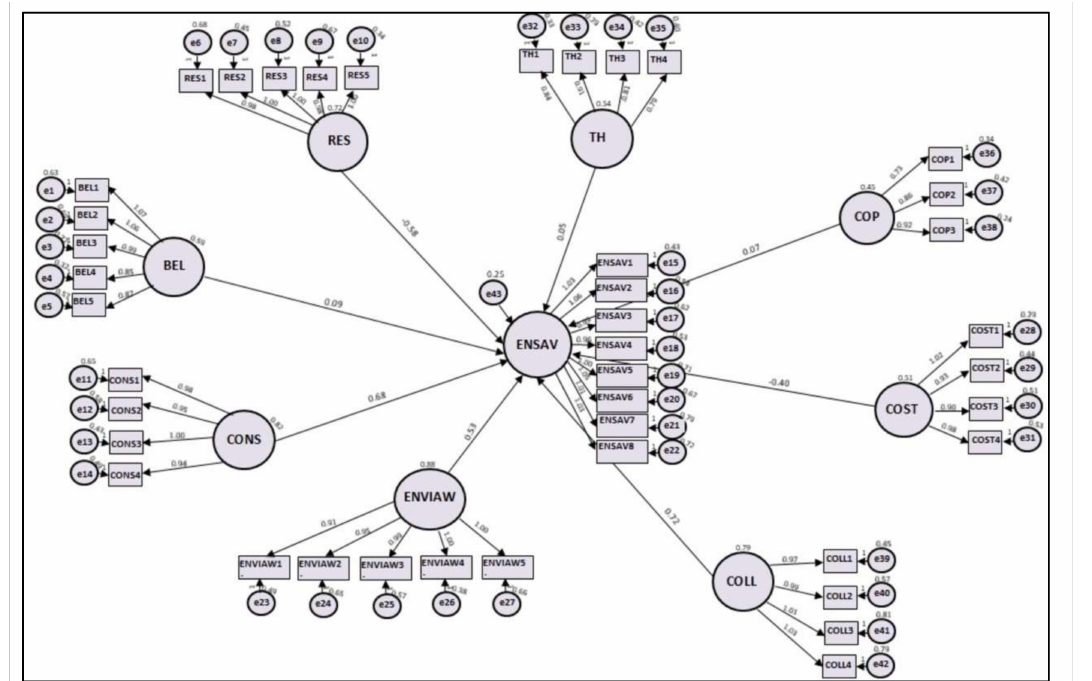
Figure 2. Assessment of the SEM